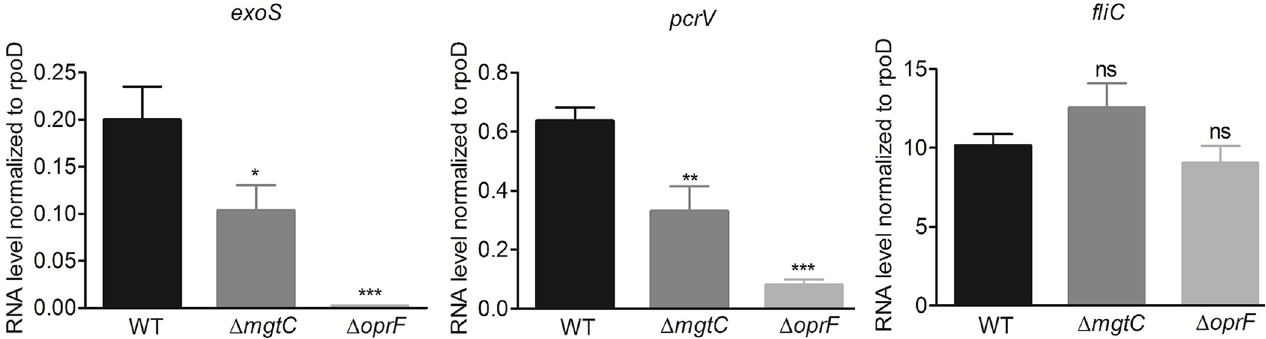
Fig 4. Expression of T3SS genes in P . aeruginosa strains residing in J774 macrophages. J774 macrophages were infected with PAO1 WT, Δ mgtC and Δ oprF strains. After phagocytosis, cells were maintained in DMEM supplemented with gentamicin. RNA was extracted from bacteria isolated from infected macrophages 1 hr after phagocytosis. The level of exoS , pcrV and fliC transcripts relative to those of the house-keeping gene rpoD was measured by qRT-PCR and plotted on the Y-axis. Error bars correspond to standard errors from at least three independent experiments. The asterisks indicate P values (One way ANOVA, where all strains were compared to WT using Dunnett’s multiple comparison post-test, � P < 0.05, �� P < 0.01, ��� P < 0.001 and ns = P > 0.05 or non- significant), showing statistical significance with respect to WT.